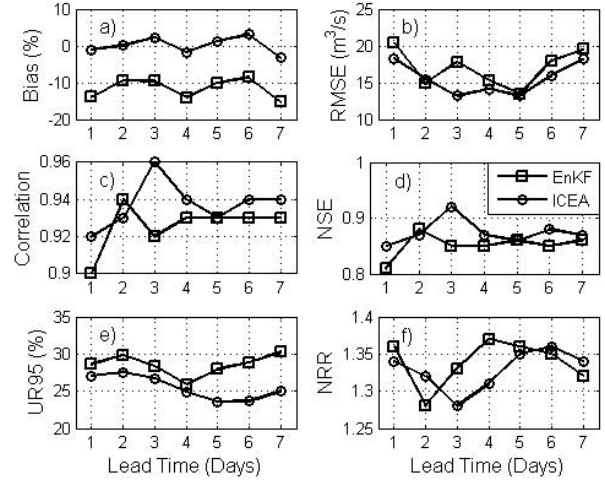
Fig. 11. Statistics for streamflow predictions at various lead times from the stand-alone EnKF and ICEA, including: (a) Bias, (b) RMSE, (c) Correlation, (d) NSE, (e) UR95, and (f)